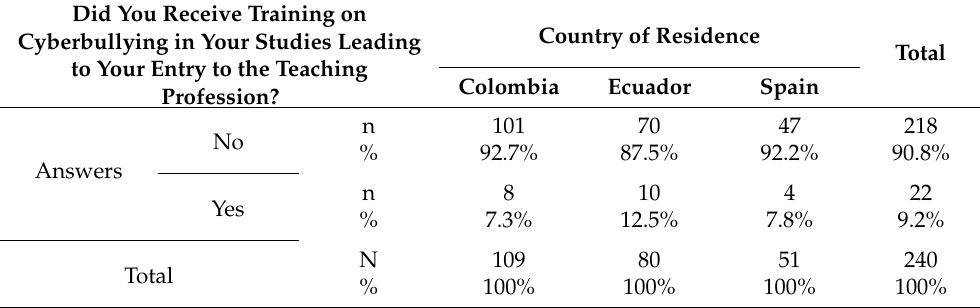
Table 6. Cross-categorization of the variable “In the studies that allowed you to enter the teaching profession, did you receive training on cyberbullying” and the variable “Country of